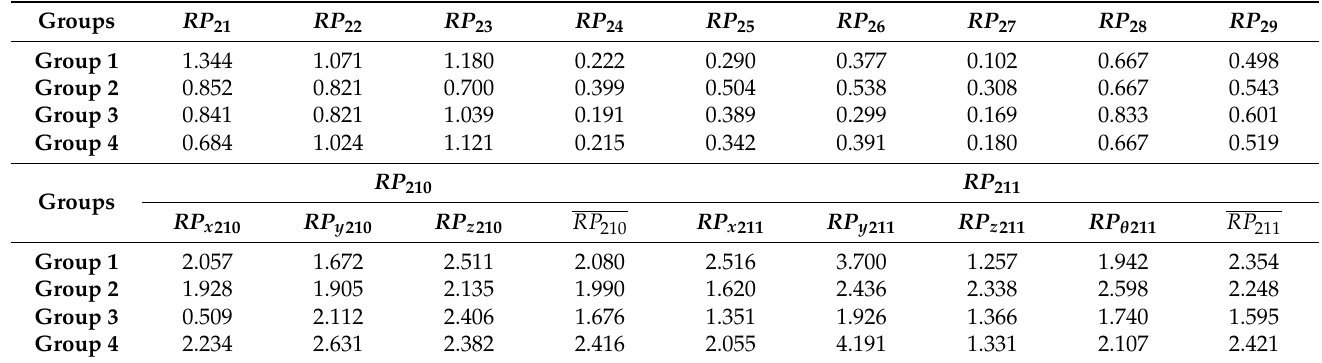
Table 5. Differences of the four group experiments.